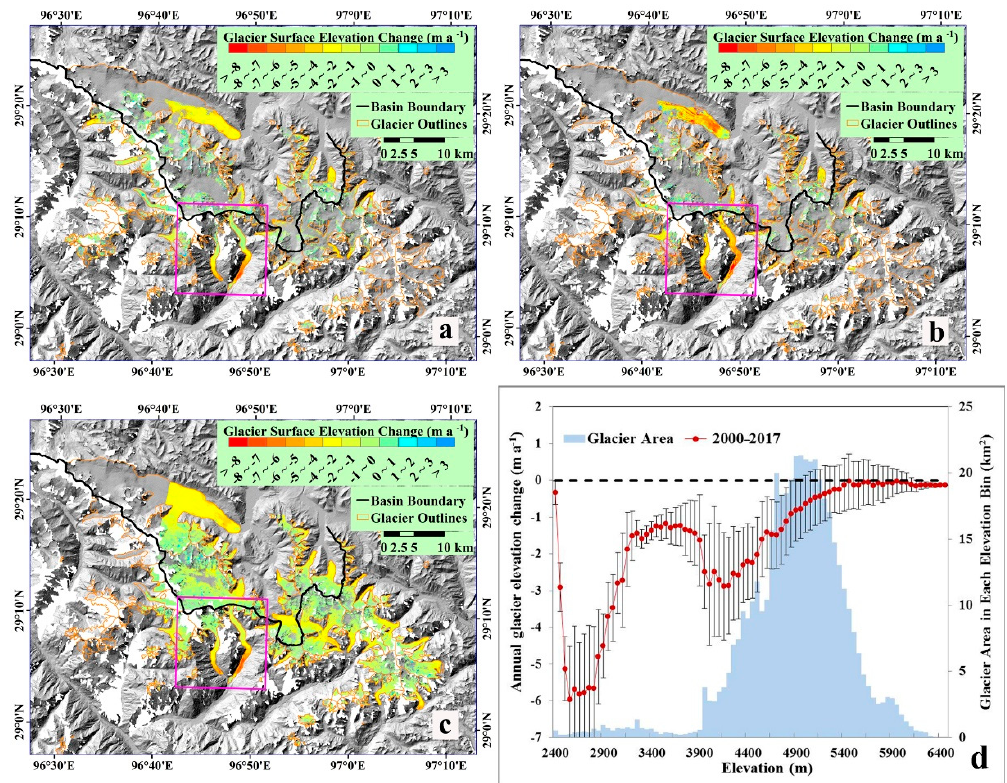
Figure 10. Annual glacier elevation change in the ENM. ( a ): 2000–2013; ( b ): 2013–2017; ( c ): 2000–2017; ( d ): Annual glacier elevation change versus elevation in 2000–2017. The purple rectangle is the sample glaciers described in Figure 10.